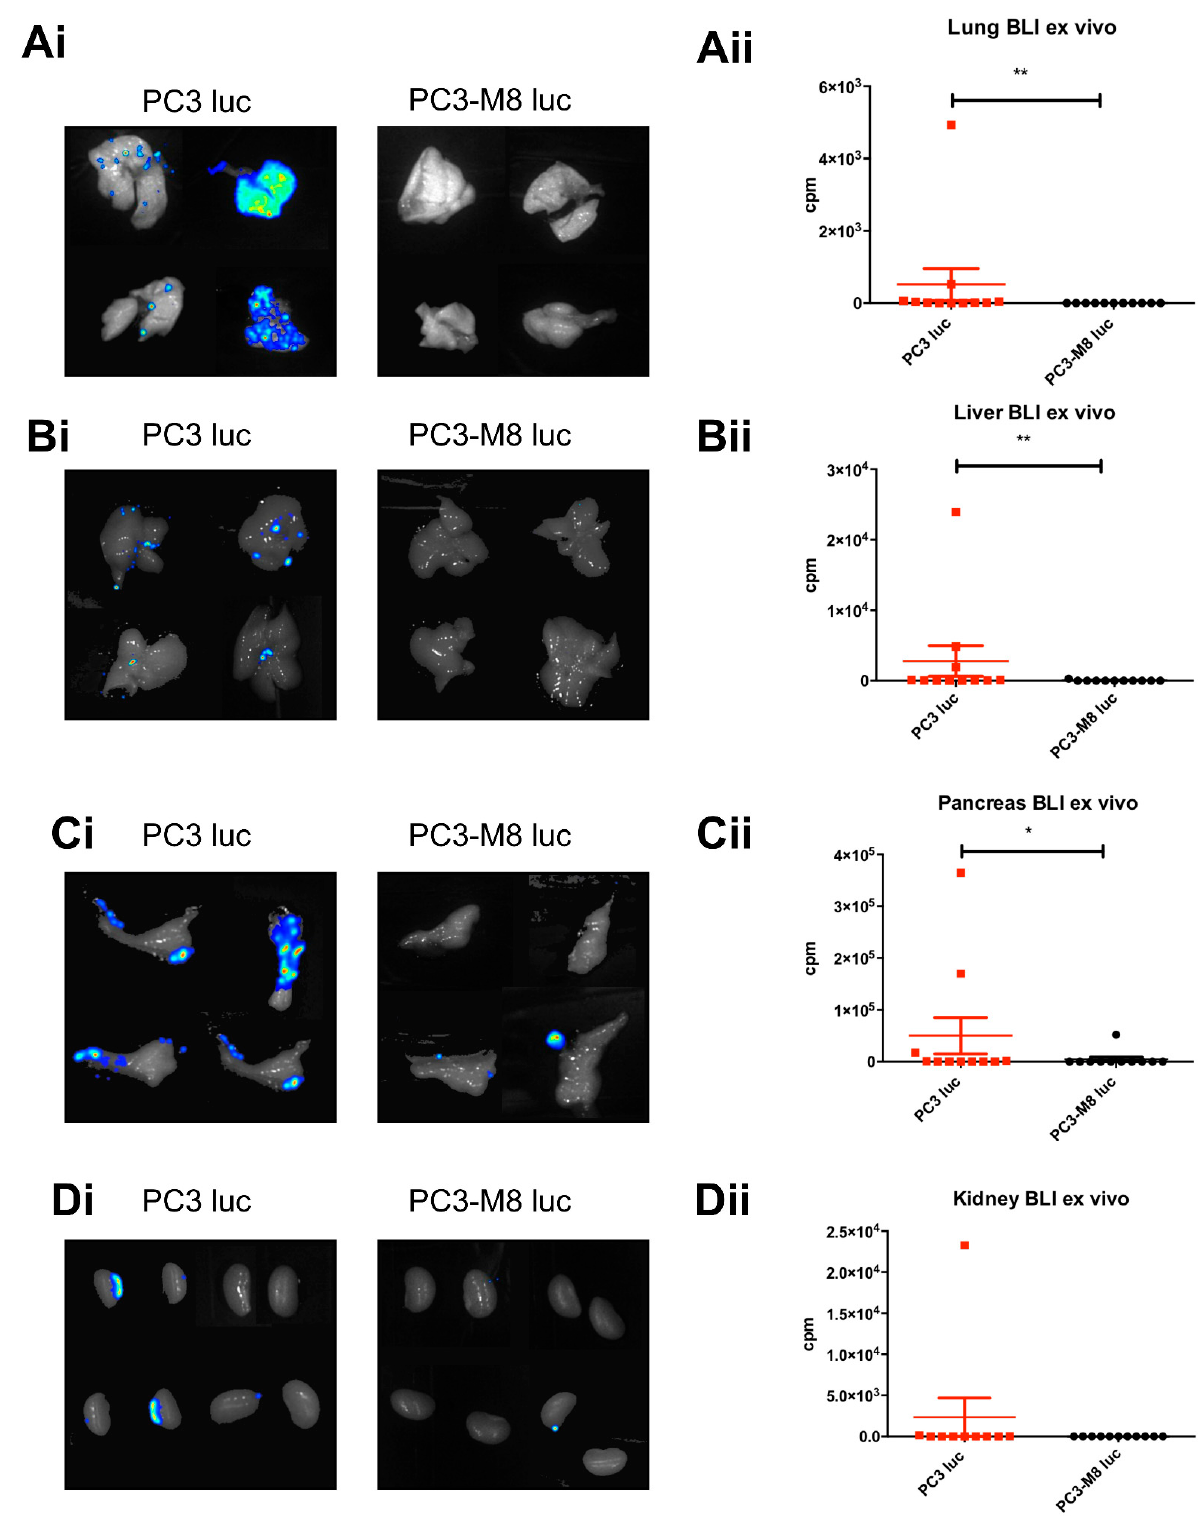
Figure 4. TRPM8 overexpression inhibits PCa cells’ metastatic dissemination. Representative images of bioluminescence in the lungs ( Ai ), liver ( Bi ), pancreas ( Ci ), and kidneys ( Di ) of mice 5 weeks after orthotopic grafts with PC3 luc (red dots) or PC3–M8 luc (black dots). Quantification of biolumines- cence in the lungs ( Aii ), liver ( Bii ), pancreas ( Cii ), and kidneys ( Dii ) of mice 5 weeks after orthotopic grafts (n = 11 mice/condition; statistical significance: * = p < 0.05; ** = p < 0.01, Mann–Whitney